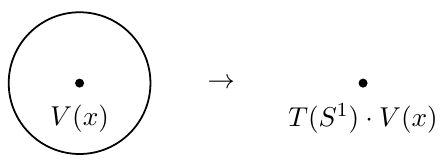
Figure 2 . The duality line T in the two-dimensional Ising CFT defines a (non-invertible) map on the local operators by encircling a local operator V ( x ) and shrinking the circle. This defines an action on the Hilbert space of states via operator-state